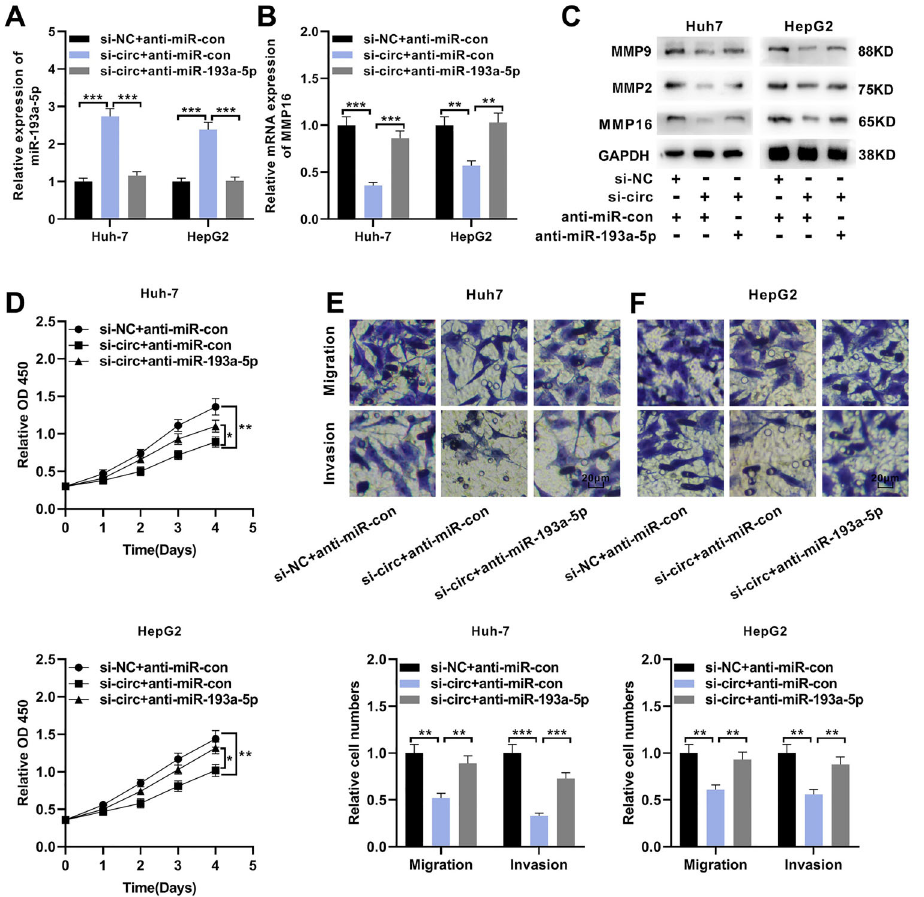
Figure 5. Circ_0001806 enhances the multiplication and invasion of hepatocellular carcinoma (HCC) cells through miR-193a-5p/ MMP16 axis. Huh-7 and HepG2 cells were transfected with si-NC + anti-miR-Con, si-circ_0001806#1 + anti-miR-Con, or si- circ_0001806#1 + anti-miR-193a-5p. A , qRT-PCR was used to detect the expression of miR-193a-5p in Huh-7 and HepG2 cells. B , qRT-PCR was used to detect the expression of MMP16 mRNA in Huh-7 and HepG2 cells. C , Western blot was used to detect the expression of MMP16, MMP2, and MMP9 protein in Huh-7 and HepG2 cells. D , CCK-8 method was used to detect the multiplication of Huh-7 and HepG2 cells after transfection. The transwell experiment was employed to detect the migration and invasion of Huh-7 cells ( E ) and HepG2 cells ( F ) after transfection (scale bar 20 m m). Data are reported as means ± SD. *P o 0.05, **P o 0.01, and ***P o 0.001